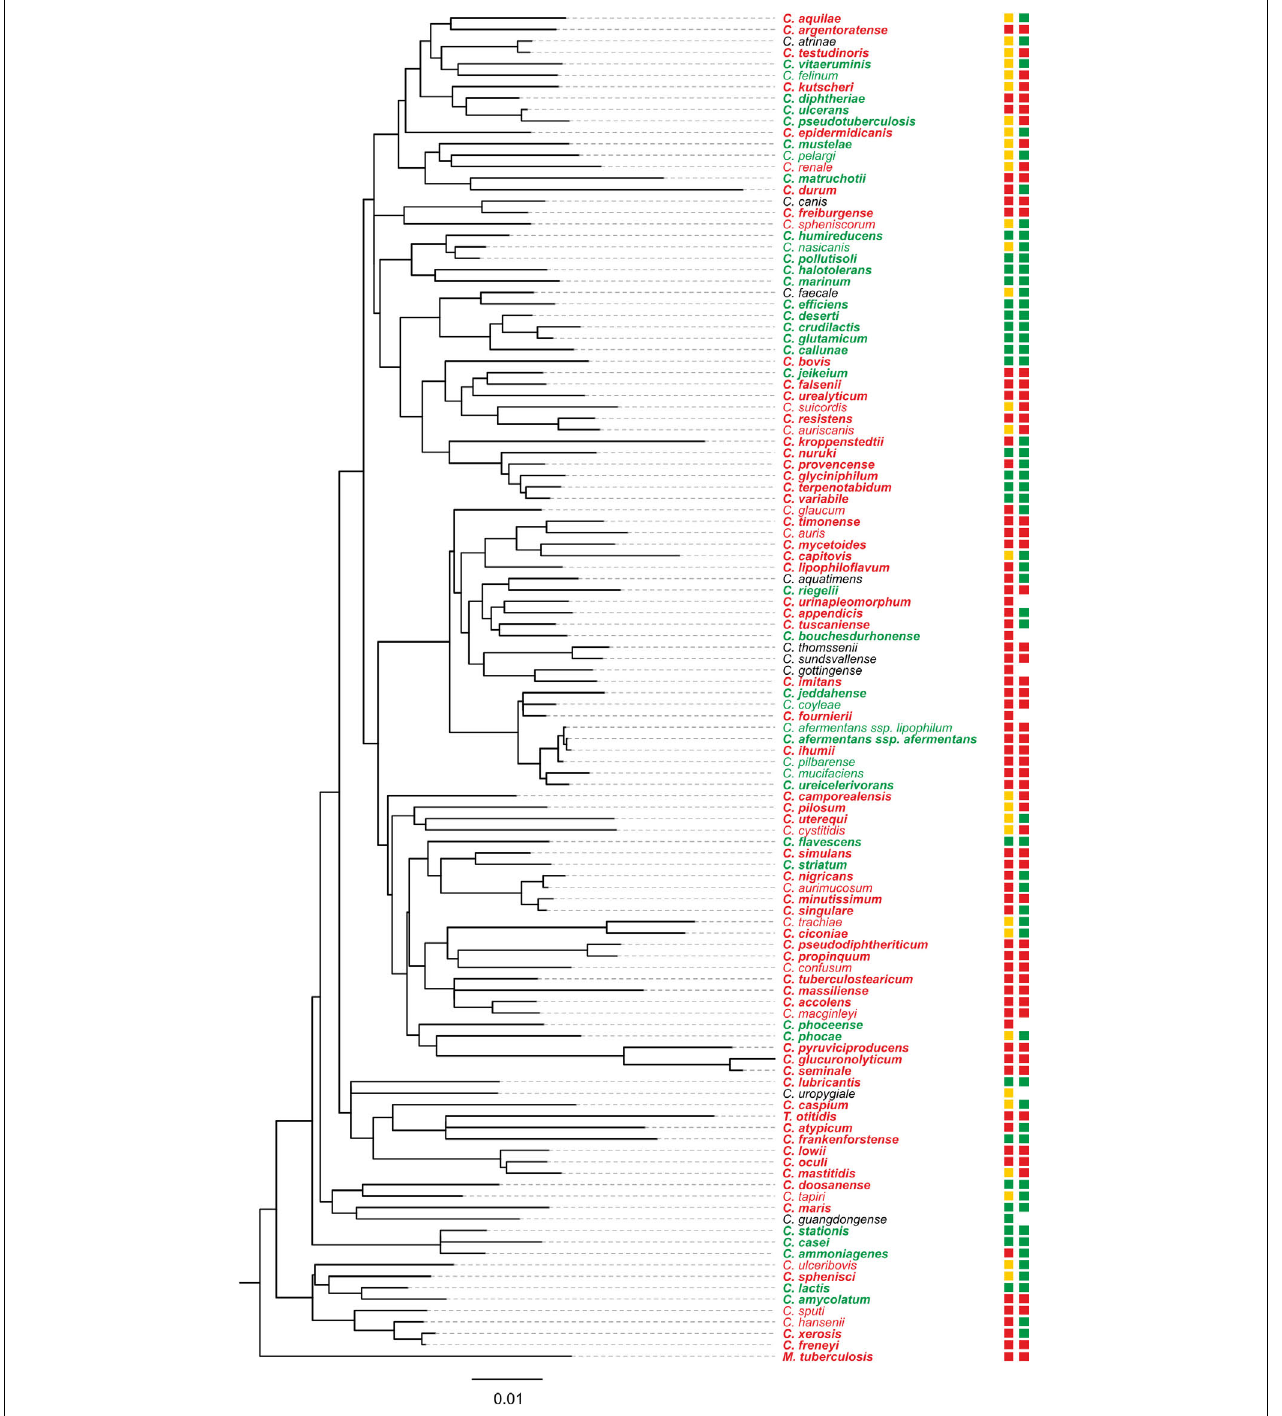
FIGURE 6 | Phylogenetic tree of the genus Corynebacterium with additional species-specific information about the occurrence of a relH Cg ortholog, the respective isolation site and the biosafety level. The phylogenetic tree was generated on the basis of the respective 16S rDNA sequences using the RDP database (Cole et al., 2014). The analysis of available genomes for the presence of a relH Cg ortholog was based on a Hidden Markov model (see Materials and Methods). Species with a respective gene are shown in green, species without relH gene in red and species without an available genome in black. The genomes of species printed in bolt type are available in databases, whereas the other genomes are our unpublished data. The first box after the species name represents the isolation site, where green illustrates environmental isolates, yellow those isolated from animals, and red human isolates. The second box corresponds to the biosafety classification (according to German law); green: level one; red: level two; no box: no classification available.